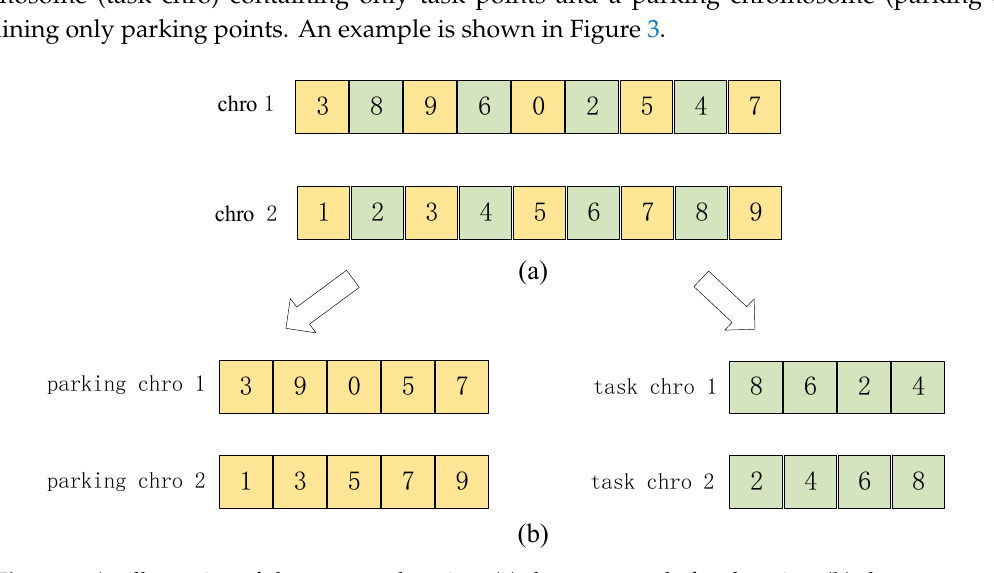
Figure 3. An illustration of chromosome layering: ( a ) chromosomes before layering; ( b ) chromosomes after layering.